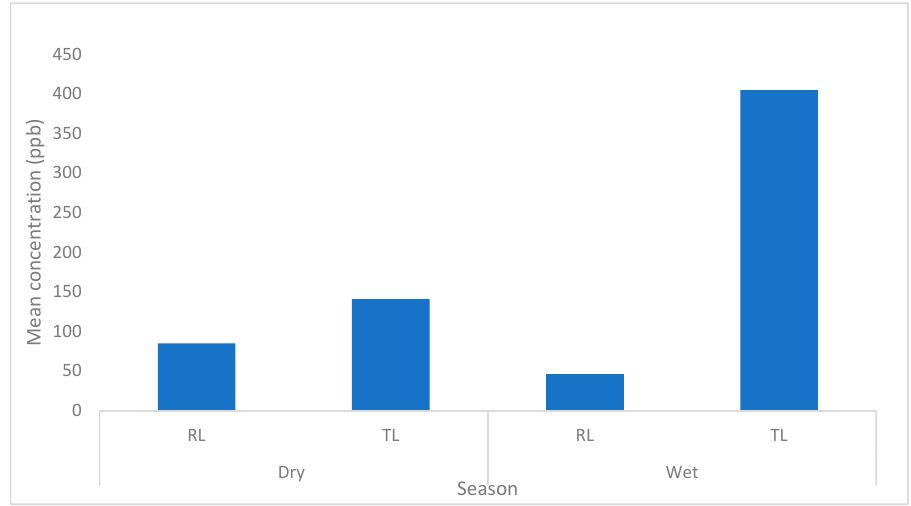
Figure 7 . Mean concentration of PAHs in raw and treated leachate. Figure 7. Mean concentration of PAHs in raw and treated